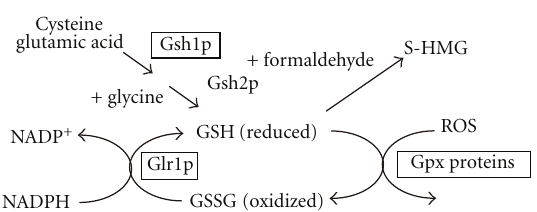
Figure 3: Schematic drawing of GSH dynamics and its regulation by Yap1. The proteins enclosed within the boxes represent factors found to be induced by Yap1 at the level of transcription. Enzymes: Gsh1p: γ -glutamylcysteine synthetase; Gsh2p: glutathione syn- thetase; Glr1p: glutathione reducatse; Gpx: glutathione peroxidase. S -HMG: S -hydroxymethyl glutathione; GSH: reduced form of glutathione; GSSG: oxidized form of glutathione; ROS: reactive oxygen